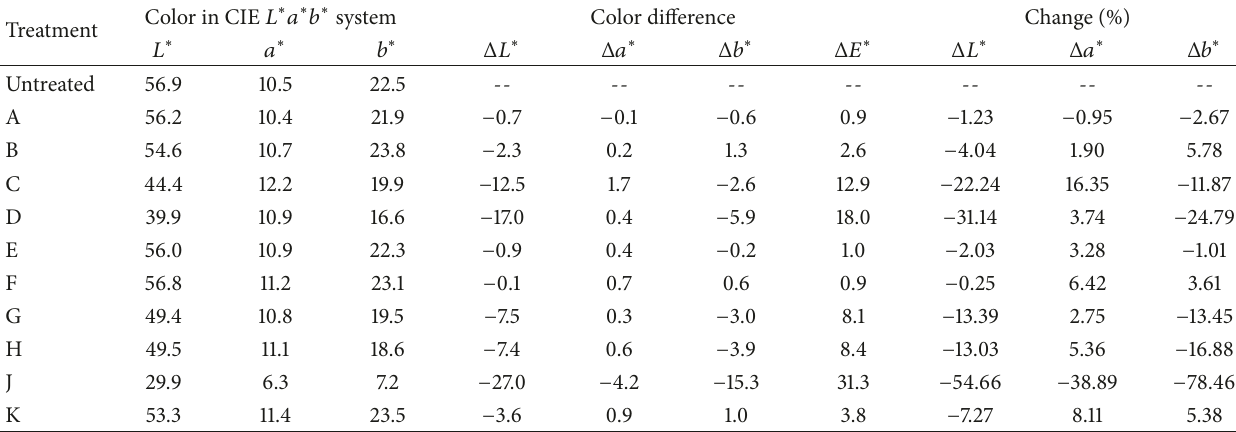
Table 2: Effect of media treatments on the color change of bamboo